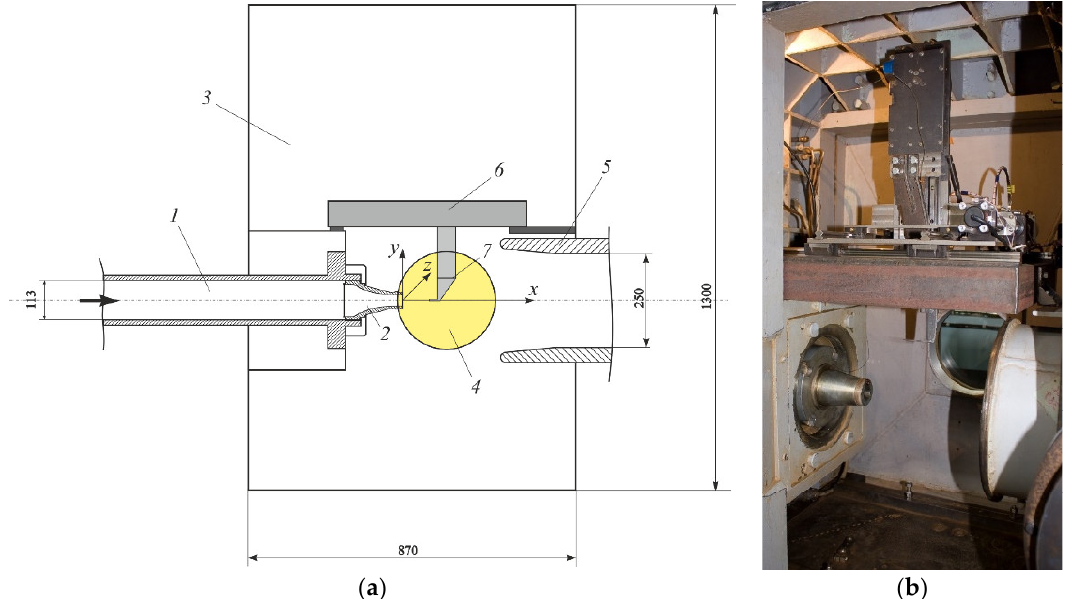
Figure 3. Scheme ( a ) and photo ( b ) of the test chamber of the jet unit of T-326 wind tunnel: 1—settling chamber; 2—nozzle; 3—test chamber; 4—observation window; 5—diffuser; 6—traversing gear intended for scanning the flow with measuring probes, 7—Pitot-tube pylon. The black bold arrow shows a flow direction.